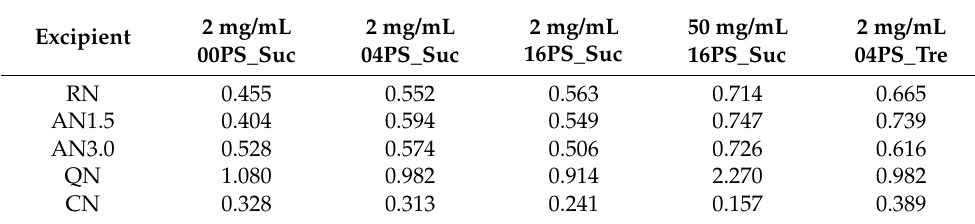
Table 5. Specific surface area of the created formulations in [m 2 g − 1 ]. n = 1, two samples were pooled in one measuring tube to reach the needed sample mass.